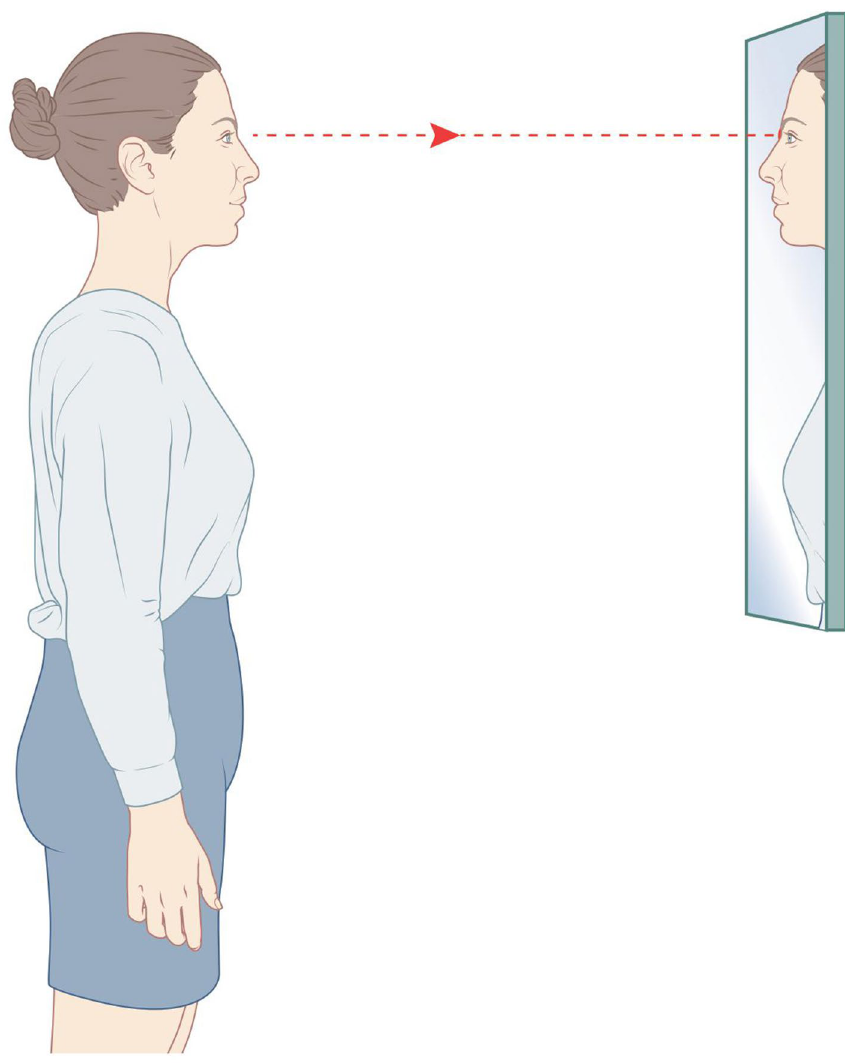
Figure 1. Natural head position. Created by Rogier Trompert Medical